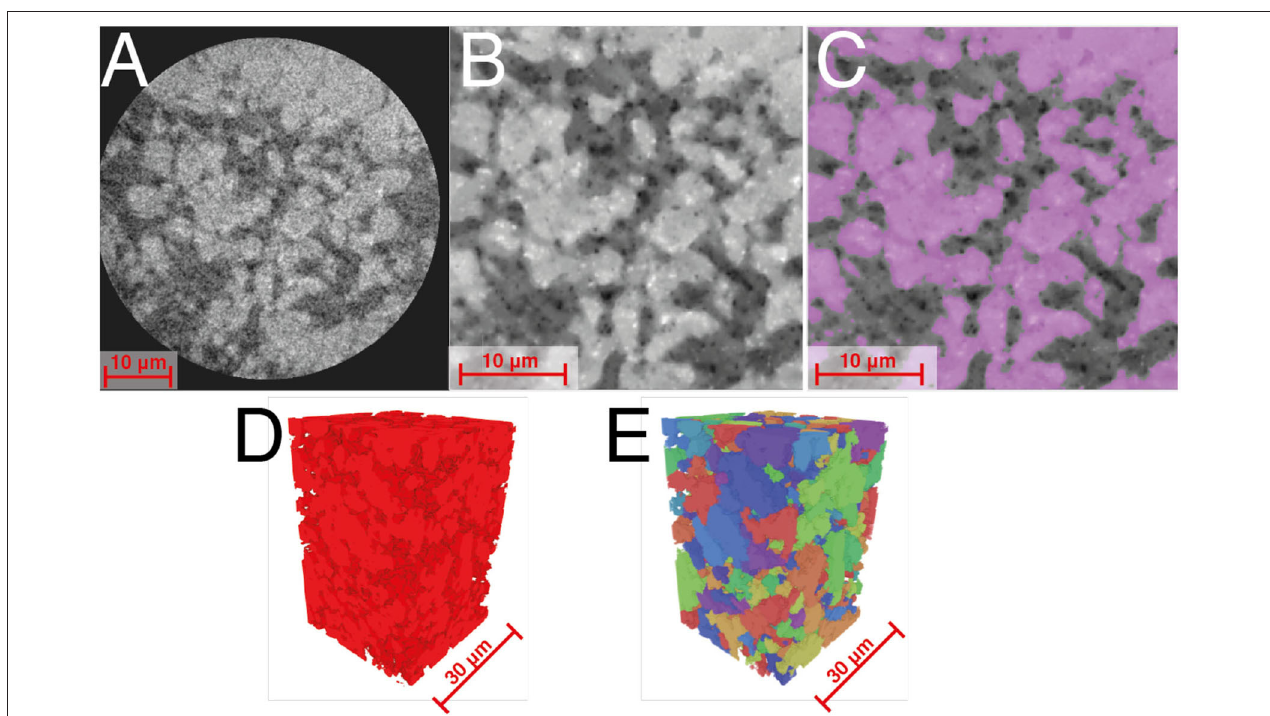
FIGURE 3 | (A) The raw nano-XRM image, (B) cropped and filtered image, (C) grains identified by machine learning, (D) segmented 3D image, and (E) separated grains.